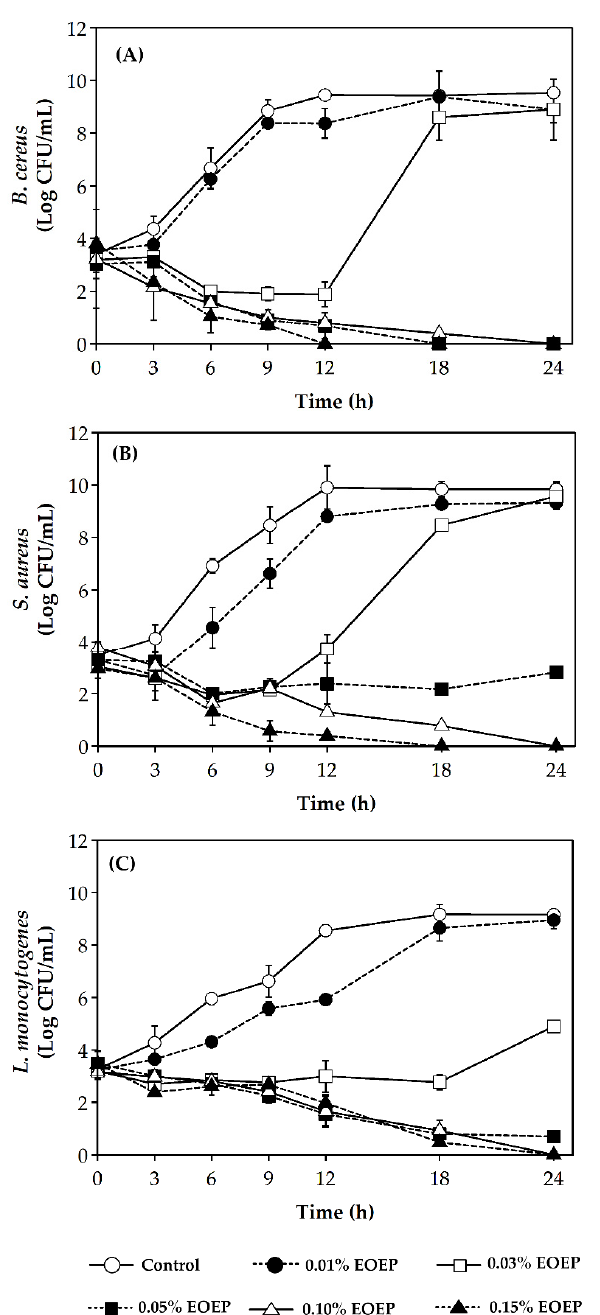
Figure 3. Killing curves for various concentrations of EOEP against B. cereus ( A ), S. aureus ( B ) and L. monocytogenes Scott A ( C ).